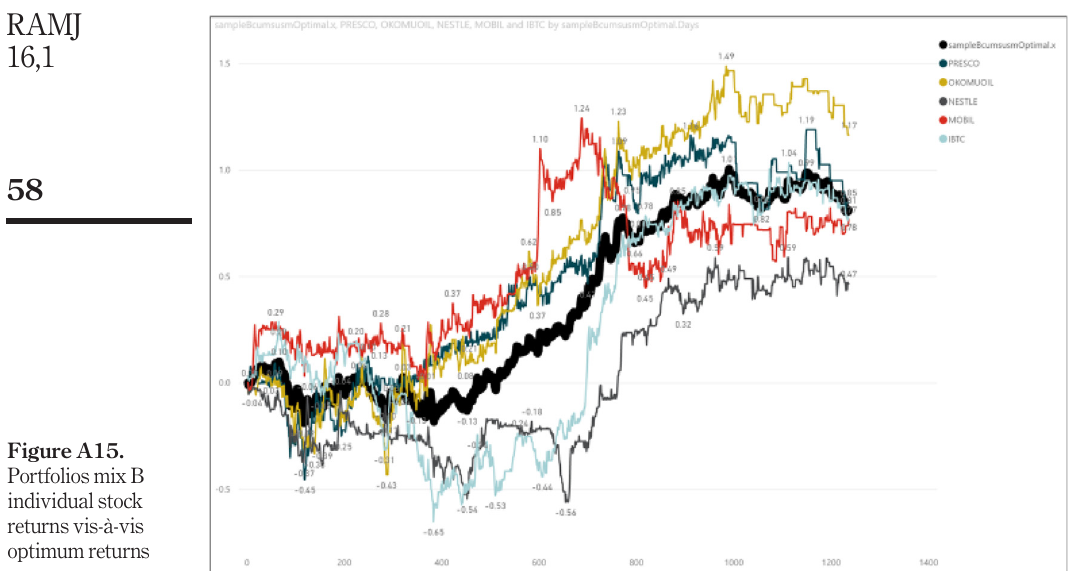
Figure A15. Portfolios mix B individual stock